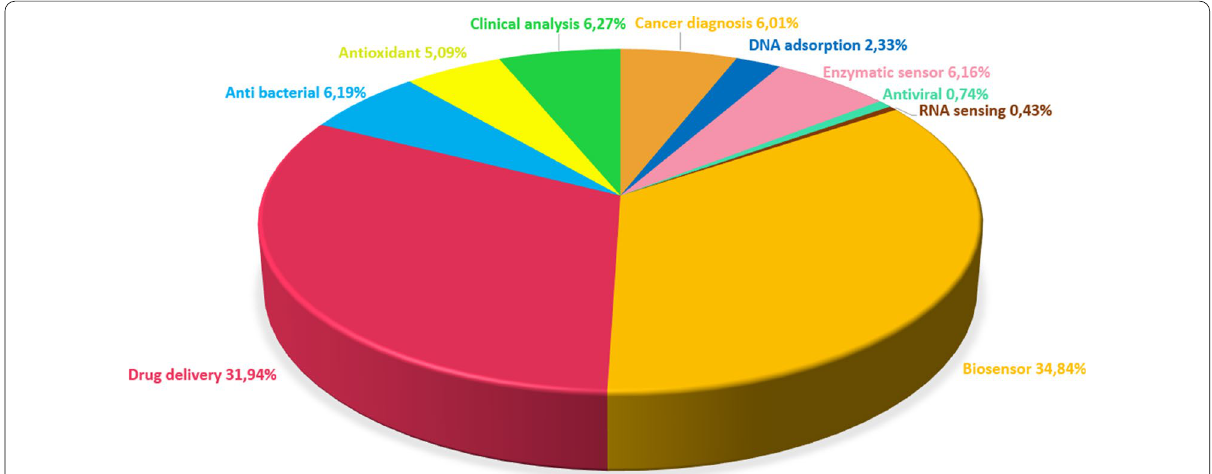
Fig. 7 Pie chart showing the distribution of CNTs in biomedical